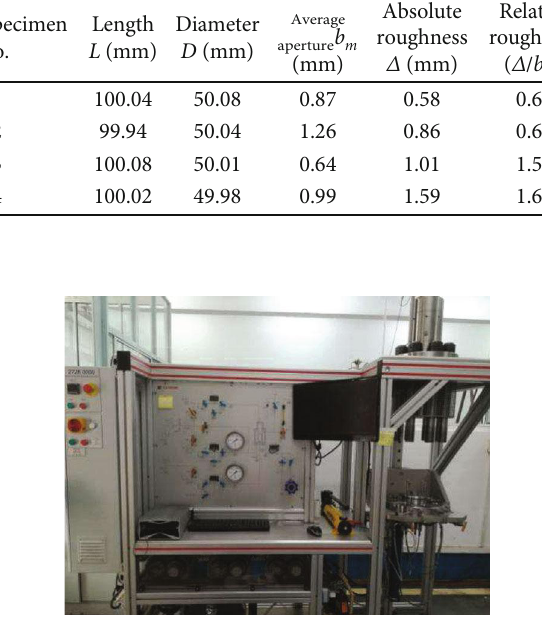
Figure 3: Triaxial multi fi eld coupling test